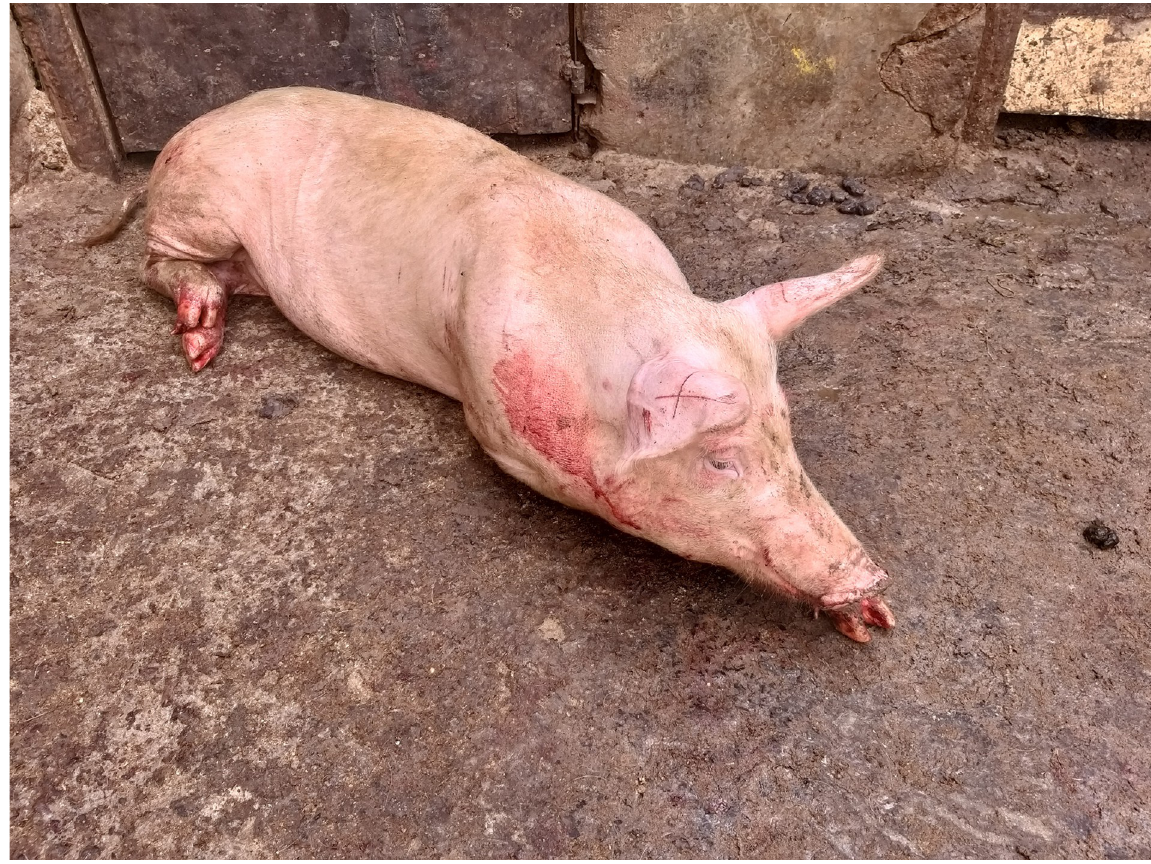
Fig 3. An image showing an earmark on a pig, as made by slaughterhouse